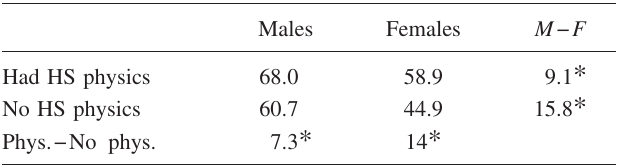
TABLE VII. Average FMCE post-test scores for males and fe- males who did and did not take high school physics. The asterisk (cid:1) * (cid:2) indicates that the difference is statistically significant at p (cid:3)